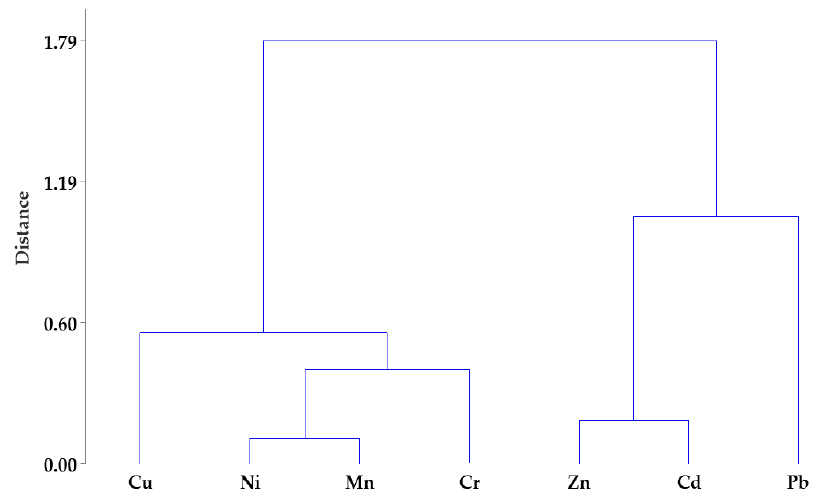
Figure 4. Hierarchical dendrogram for the seven PTEs in dust from selected highways, pedestrian bridges and urban roads in Eastern Uganda.